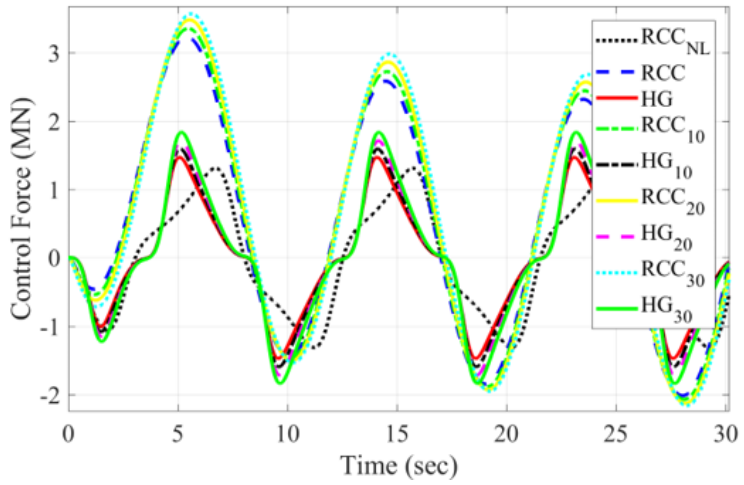
Figure 13. Control forces for the first 30 s of 100 s duration for all cases,